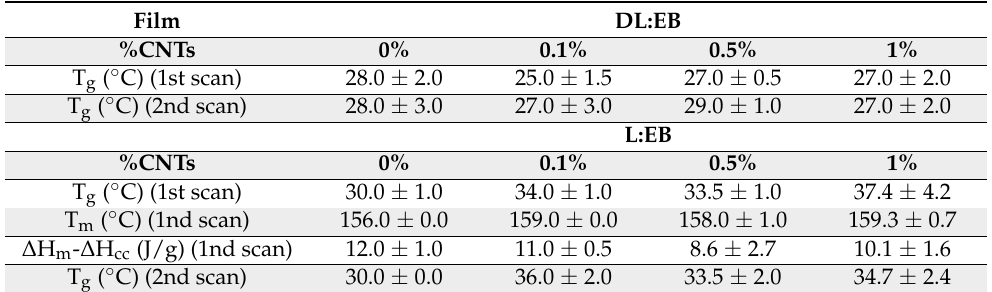
Table 3. Thermal properties of the resulting films after their processing and incorporation of CNTs. Film DL:EB